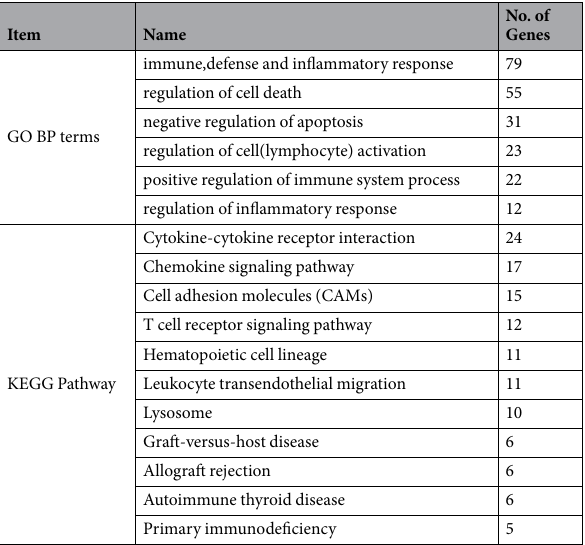
Table 3. GO biological process terms and KEGG pathway for DEmRNAs co-expressed with